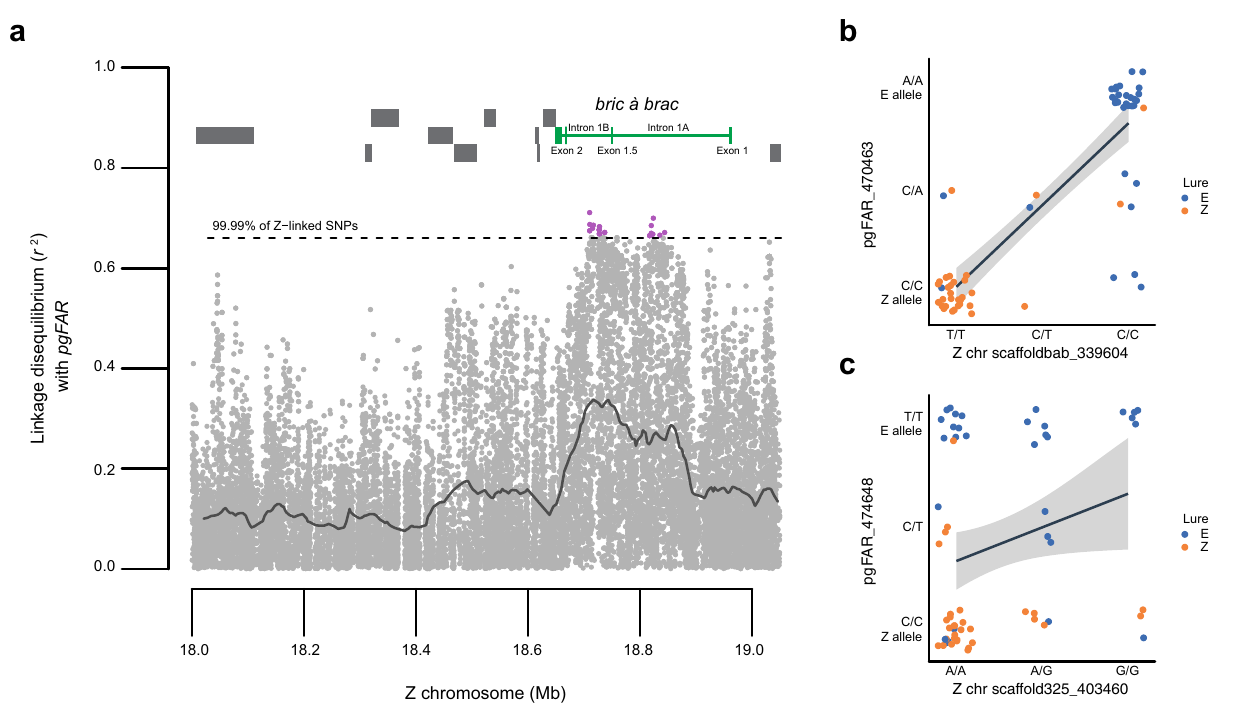
Fig. 4 Linkage disequilibrium between the autosomal gene controlling female pheromone blend ( pgFAR ) and the Z chromosome. a Of amino-acid changing mutations detected at pgFAR , the one showing maximum r 2 with each Z-linked polymorphism (281,385 SNPs) is plotted for the 18 – 19 Mb associated interval on the Z chromosome (22,689 SNPs) ( n = 62 males). Purple points depict r 2 values falling above the 99.99th percentile (dashed line; r 2 = 0.66, 26 SNPs) for the ~21-Mb Z chromosome. bab gene structure (green) and neighboring genes (gray) are shown. The solid line depicts a sliding window average of r 2 (1 kb with 100-bp step). b A pgFAR SNP underlying a leucine (Z allele) to isoleucine (E allele) substitution shows a maximum chromosome-wide r 2 of 0.71 with a SNP within intron 1B of bab (position 18.71 Mb). All males homozygous for the E allele (A/A) at pgFAR were homozygous for the C SNP at bab (23 individuals). Most males homozygous for the Z allele at pgFAR (C/C) were homozygous for the T SNP at bab (27 of 31 individuals, 87%). pgFAR heterozygotes were more evenly associated with bab genotypes. 71% of males caught in the E trap were pgFAR A bab1 C multilocus homozygotes (22 of 31) and 84% of males caught in the Z trap were pgFAR C bab1 T multilocus homozygotes (26 of 31). c A representative pgFAR SNP and Z-linked SNP on scaffold 325 having an r 2 value close to the Z chromosome median value of 0.06. Data ( b , c ) are presented as an estimated linear regression line (black) with a 95% con fi dence interval (gray band), and point color indicates the pheromone blend to which each fi eld-caught male was attracted. Males caught using Z and E pheromone lures are shown in orange and blue, respectively. Source data are provided as a Source Data fi